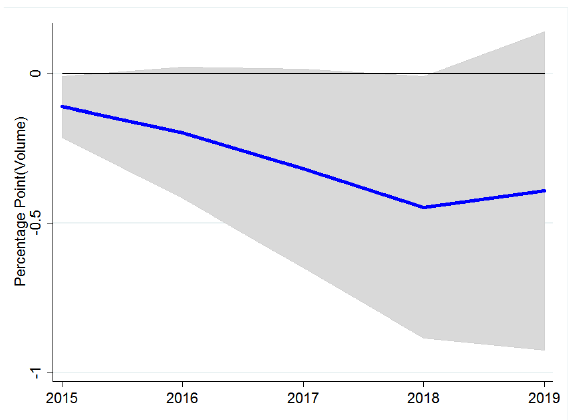
Figure 5. Cumulative Response of Volume to NGER.